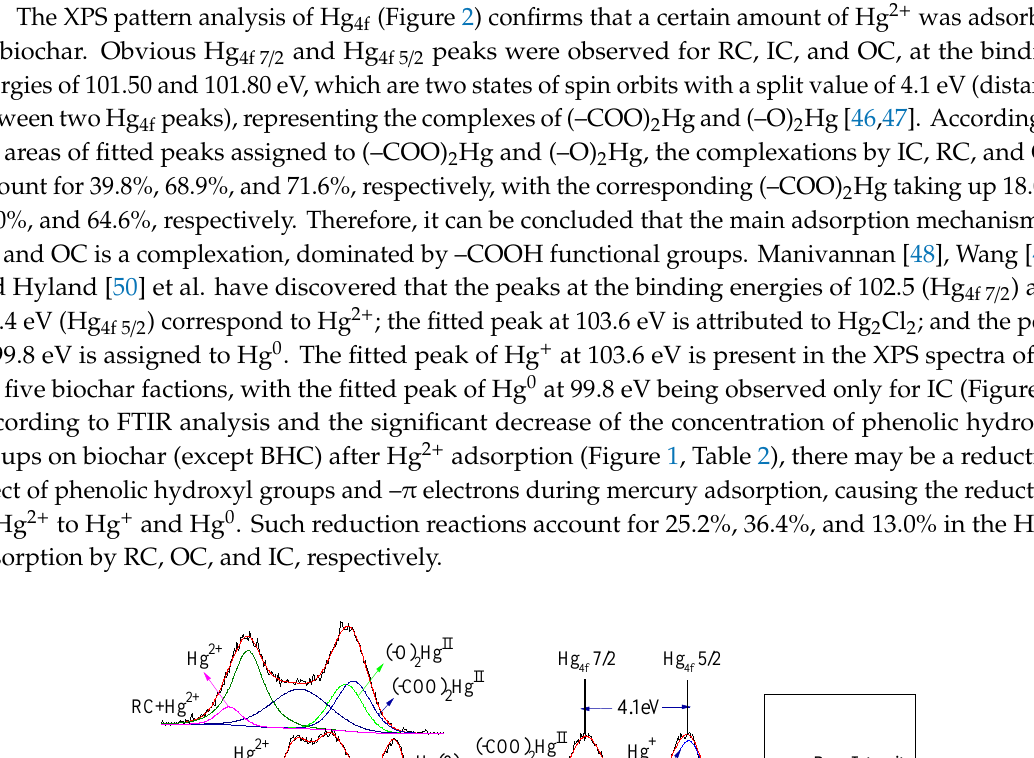
Figure 2. XPS spectra of Hg 4f after adsorption of Hg 2+ by biochars.